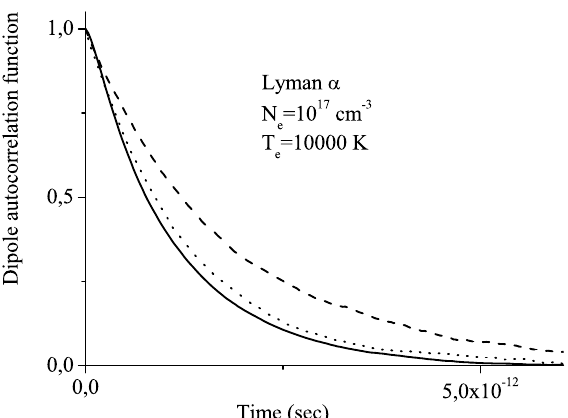
Fig. 2. Two histories (dashed and dotted lines) of the dipole autocorrelation function and their sum (solid line)